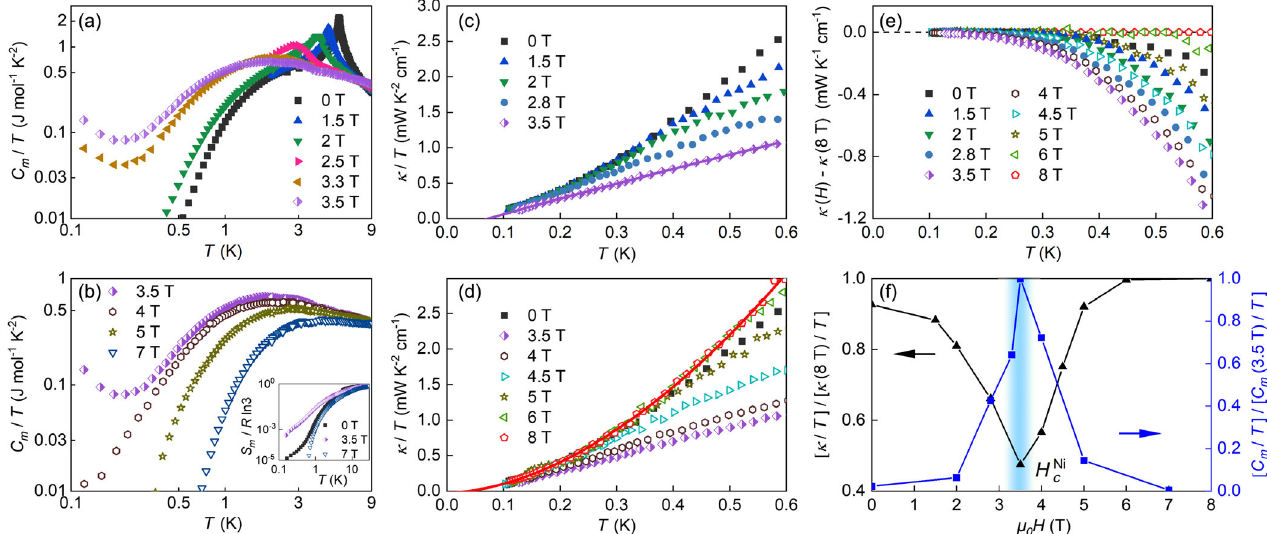
∼ 3 . 5 T, respectively. The inset of (b) shows the =T of NiNb 2 O 6 below and above μ 0 H Ni FIG. 3. (a),(b) The magnetic specific heat C c m magnetic entropy S of NiNb 2 O 6 at selected fields. (c),(d) The thermal conductivity κ =T of NiNb 2 O 6 at fields below and above H Ni m respectively. The solid lines are the fitting of the 3.5 and 8 T data to κ =T ¼ a þ bT α − 1 . (e) The influence of magnetic excitations on the thermal conductivity reflected in Δ κ ≡ κ ð H Þ − κ ð 8 T Þ . (f) The magnetic field evolution of the normalized thermal conductivity and magnetic specific heat at 0.4 K. The cyan shaded region depicts the position of H Ni c